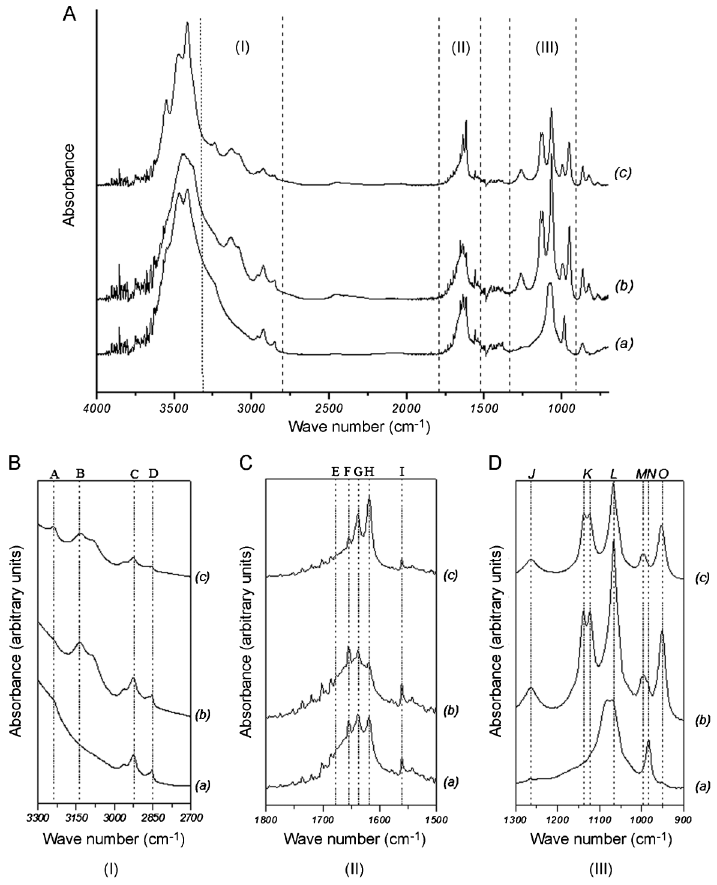
Figure 4. FTIR spectra between 4000 and 800 cm -1 of H9c2 cells after a 24-h incubation with celecoxib. A , Spectra overview: (a) 0 m M, (b) 1 m M, (c) 10 m M celecoxib. Spectra intervals: B , 3300 to 2700 cm -1 (I); C , 1800 to 1500 cm -1 (II); D , 1300 to 900 cm -1 (III). A-N were assigned as bands in those spectra. Bands A, B, J-N represent changes in DNA; bands assigned from E to I represent structural changes of proteins; C and D represent general changes in cellular structures; O represents P-O stretching in phosphorylated